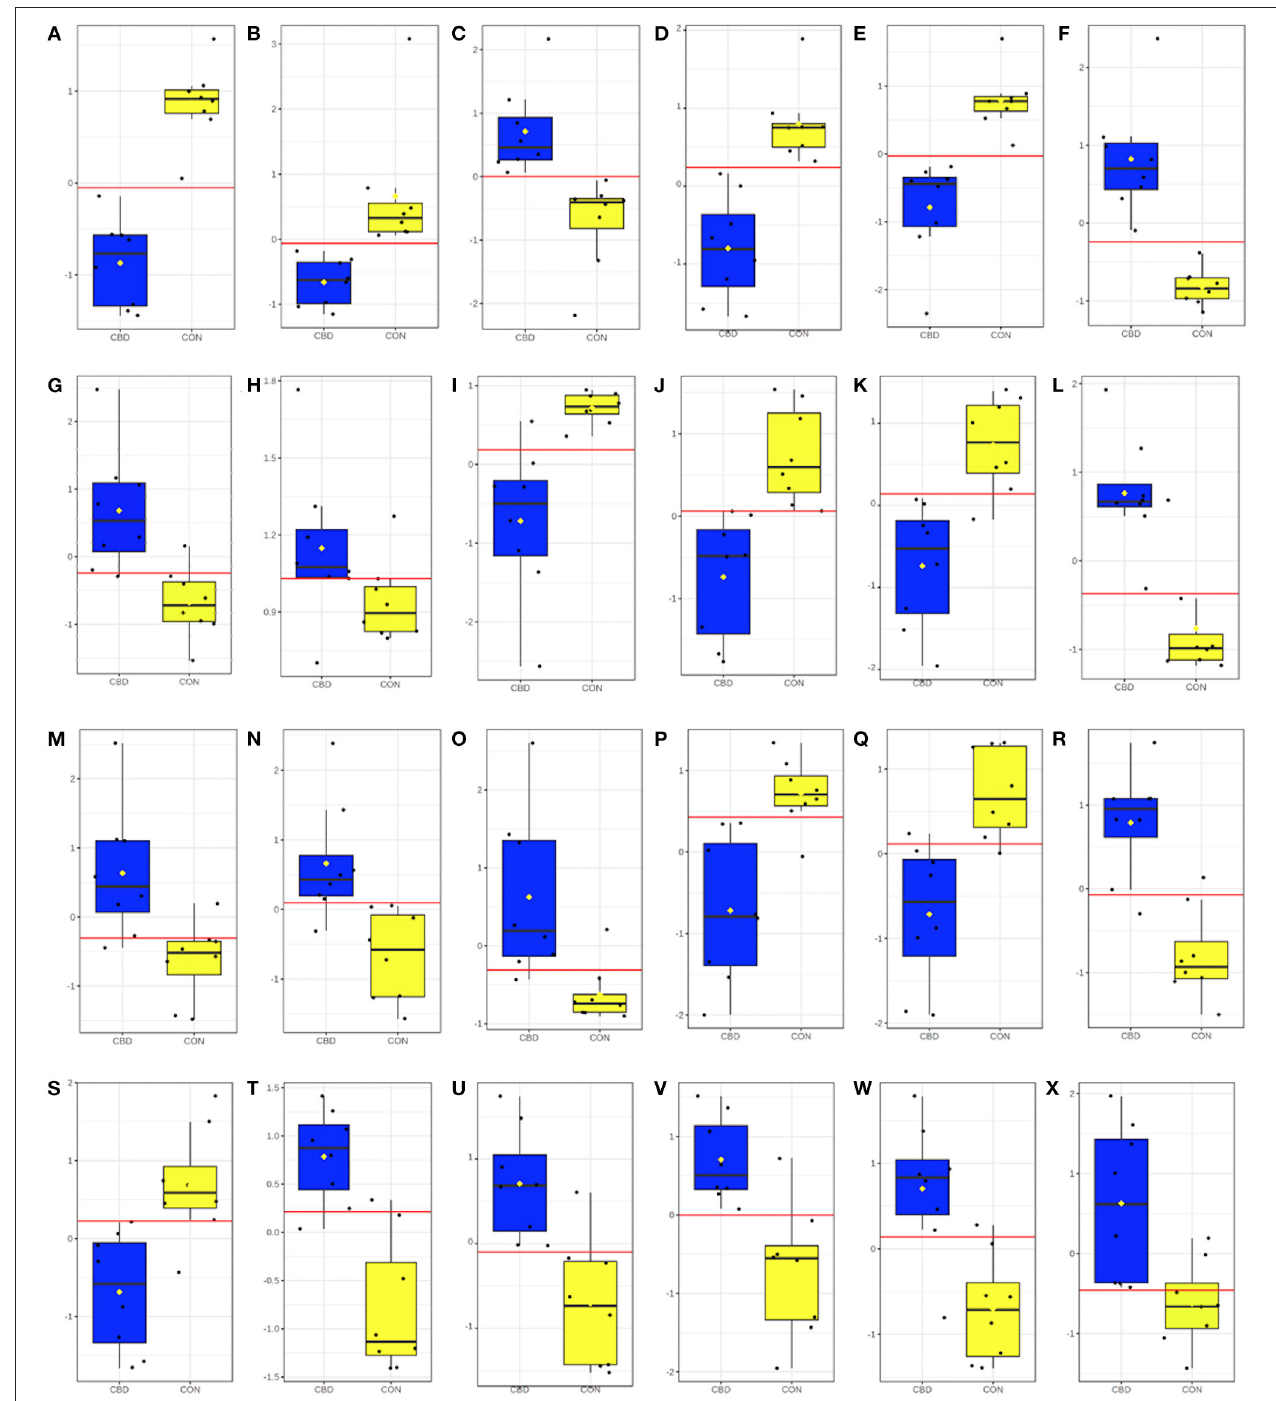
FIGURE 2 | Box and whisker plots for candidate amine/phenol-containing biomarkers altered by cannabidiol (CBD; in blue) compared to control (CON; in yellow). Candidate amine/phenol biomarkers included (A) aspartyl-glutamine (AUROC = 1.00; P < 0.001); (B) gamma-aminobutyric acid (AUROC = 1.00; P = 0.005); (C) gamma-glutamyl-gamma-aminobutyraldehyde (AUROC = 1.00; P < 0.001); (D) L-glutamate-5-semialdehyde (AUROC = 1.00; P < 0.001); (E) prolyl-glutamine (AUROC = 1.00; P < 0.001); (F) pyrimidodiazepine (AUROC = 1.00; P < 0.001); (G) 4-amino-4-deoxychorismate (AUROC = 0.98; P < 0.001); (H) trans-2,3-dihydroxycinnamate (AUROC = 0.98; P < 0.001); (I) alanyl-proline (AUROC = 0.97; P = 0.002); (J) N-acetyl-L-asparagine (AUROC = 0.97; P < 0.001); (K) (Z)-3-peroxyaminoacrylate (AUROC = 0.95; P < 0.001); (L) 1,4-diaminobutane (AUROC = 0.95; P < 0.001); (M)